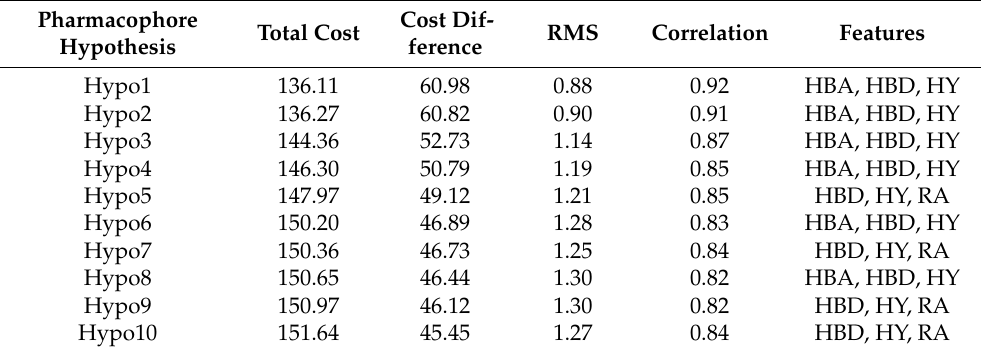
Table 1. The ten best 3D QSAR hypothetical pharmacophores constructed using a training set against EGFR